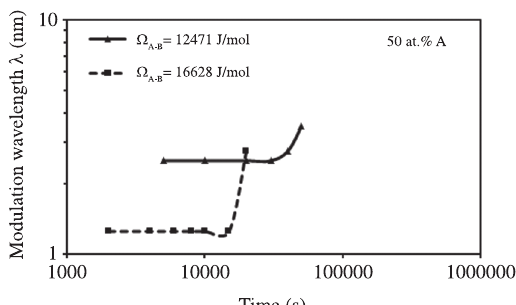
Figure 12. Plots of modulation wavelength λ vs. time t for B-50at.%A values of 12471 and 16628 J/mol. alloy at 650 K for Ω A-B